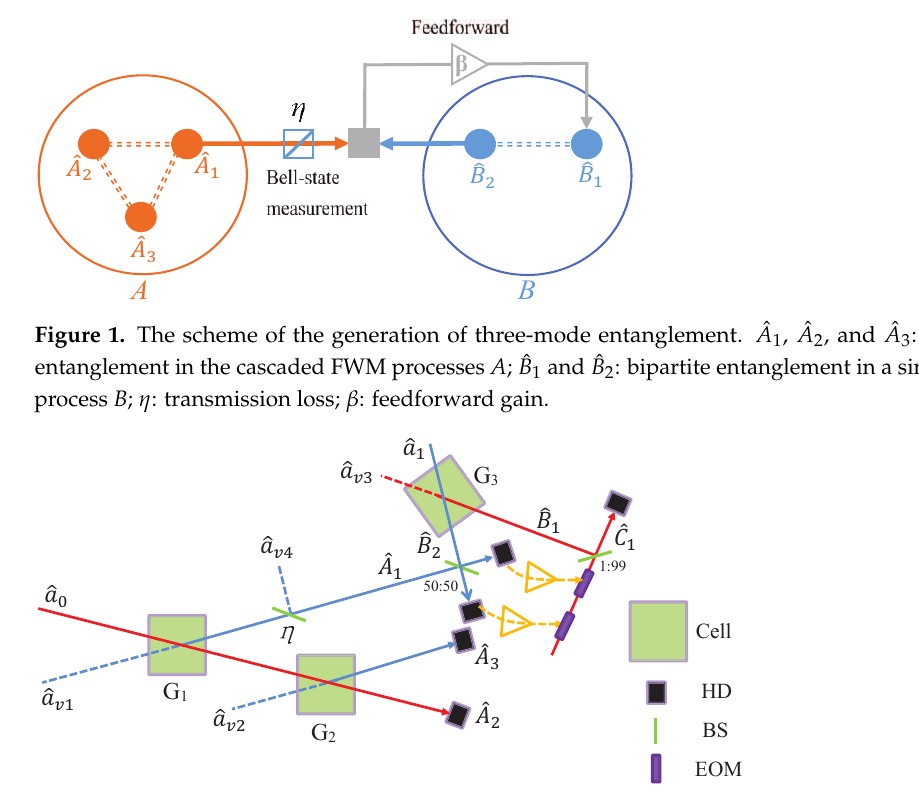
Figure 2. Detailed setup for the generation of three-mode entanglement using quantum entanglement swapping. ˆ a 0 and ˆ a 1 : coherent input signals; ˆ a ν 1 , ˆ a ν 2 , ˆ a ν 3 , and ˆ a ν 4 : vacuum inputs; ˆ A 1 , ˆ A 2 , ˆ A 3 : triple output modes in the cascaded FWM system; ˆ B 1 and ˆ B 2 : two output modes in the single FWM system; ˆ C ˆ B 1 : mode 1 after quantum entanglement swapping; G 1 , G 2 , and G 3 : the power gain values of FWM 1 , FWM 2 , and FWM 3 , respectively; η : transmission loss; 50:50: beam splitter; 1:99: highly reflecting mirrors; β : feedforward gain; HD: homodyne detector; EOM: electro-optic modulator. Equations (1)–(5) can also be expressed in terms of the quadrature operators as